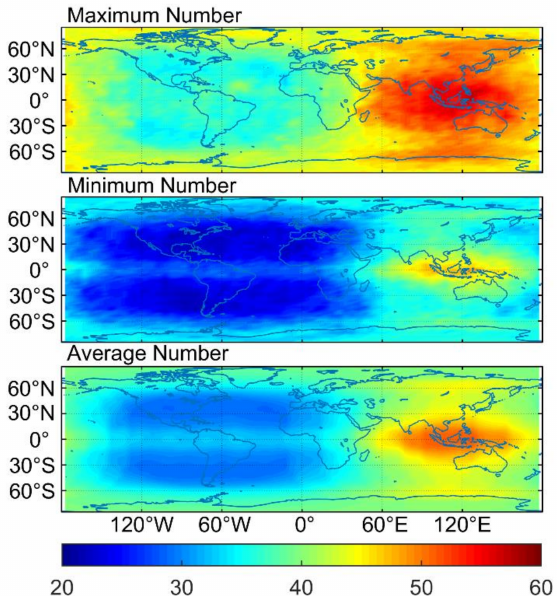
Figure 1. Global maps of maximum, minimum and average number of visible satellites for five- system combination on DOY 122 of 2020.